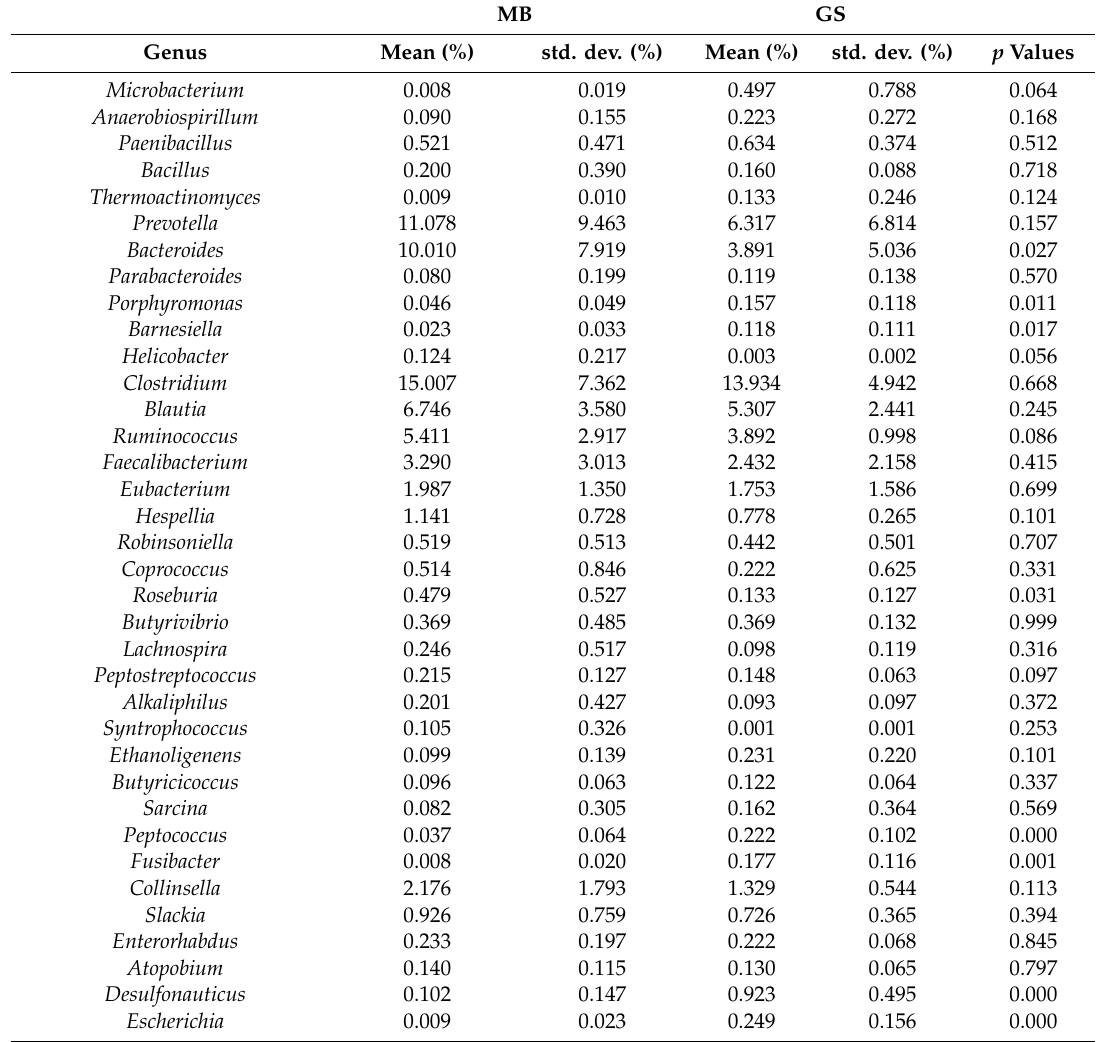
Table 5. Mean relative frequency of abundance (%) and corresponding standard deviation (SD) (%) of the genera identified in the caeca of mixed breeds (MB) and German Shepherd (GS) dogs. The species indicated are those showing a mean relative frequency of abundance ≥ 0.1% in at least one group. p values in bold are those who are significantly di ff